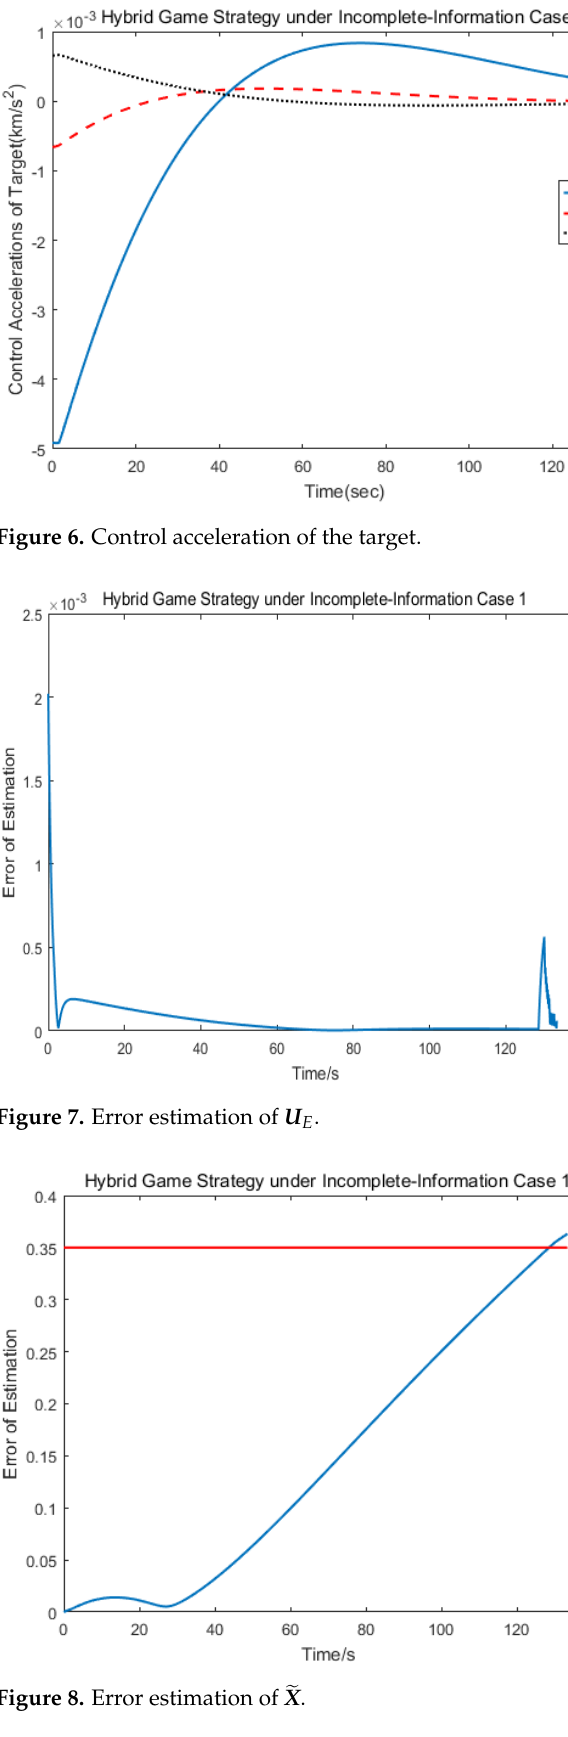
Figure 8. Error estimation of (cid:101) X